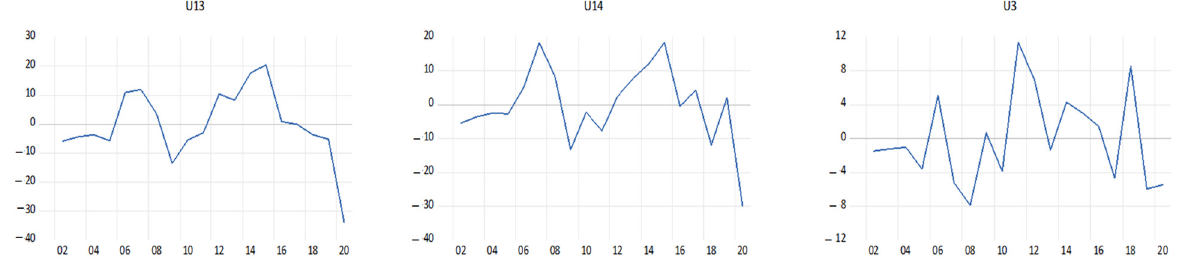
Figure 3. The residual-based ADF test for Test